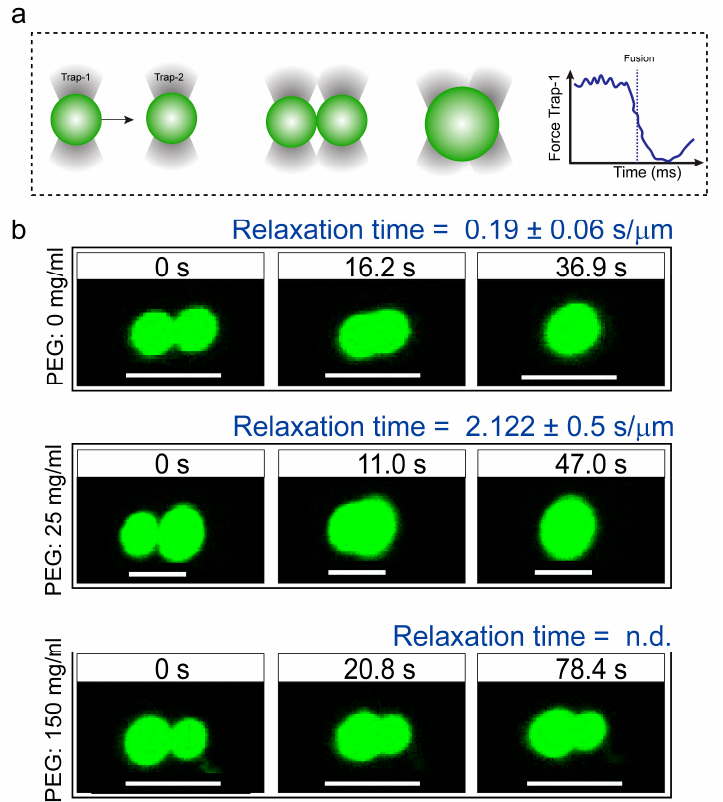
Figure 2. Coalescence dynamics of suspended condensates provide insight into FUS FL droplet material states. ( a ) Experimental scheme of RNP condensate fusion using a dual-trap optical tweezer. ( b ) Controlled fusion of suspended FUS FL droplets by the optical tweezer in the presence of 0 (top), 25 (middle), and 150 (bottom) mg/mL of PEG8000. The normalized relaxation times are indicated in each case. For 150 mg/mL PEG samples, droplets did not completely fuse. Scale bar = 5 µ m. n.d.: not determined. Additionally, see Movies